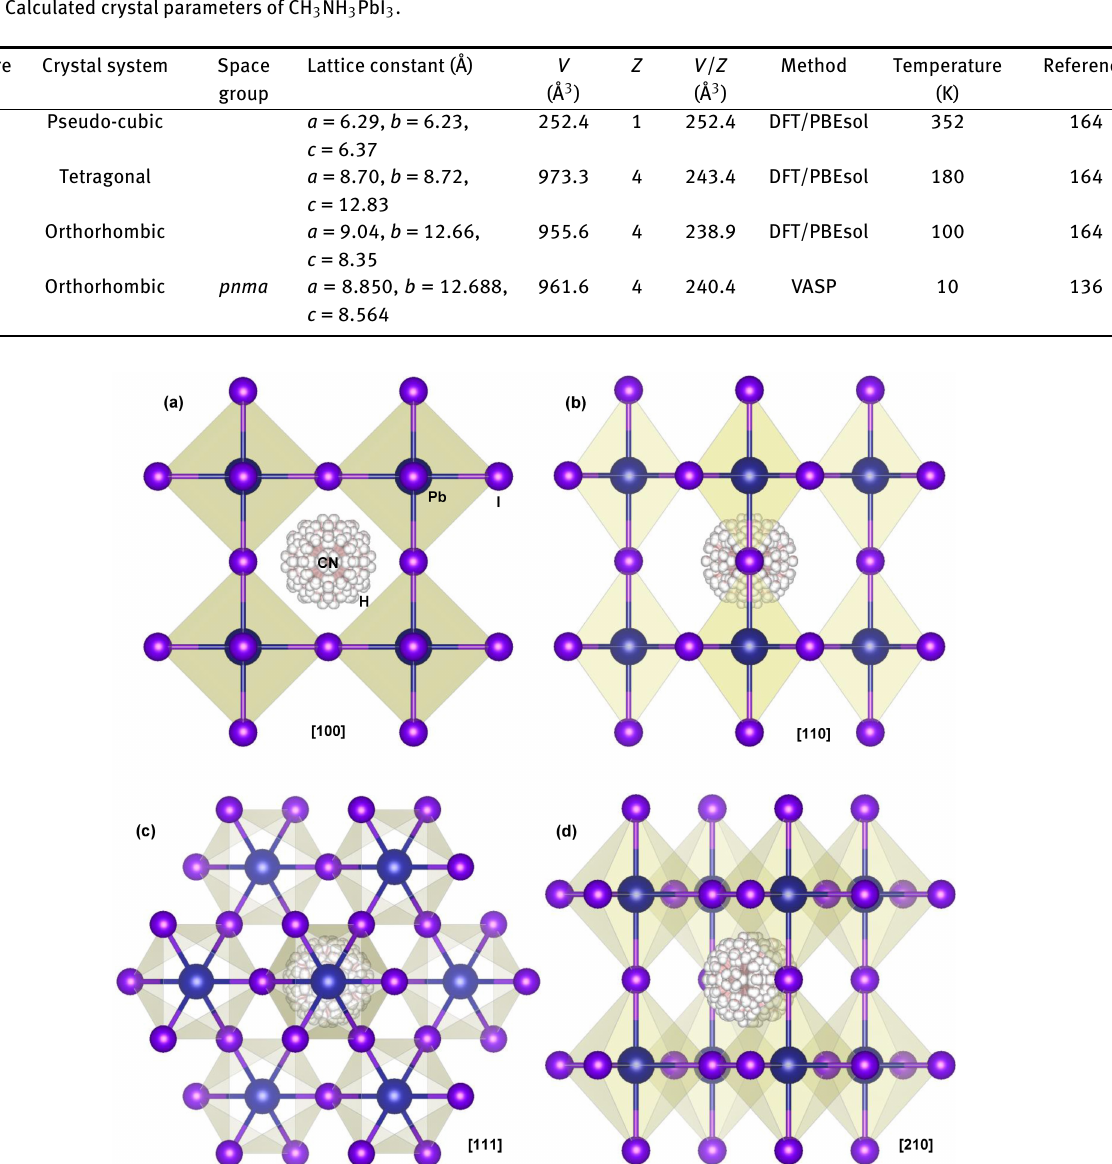
Figure 12: Structural models of cubic CH 3 NH 3 PbI 3 observed along (a) [100], (b) [110], (c) [111], and (d)